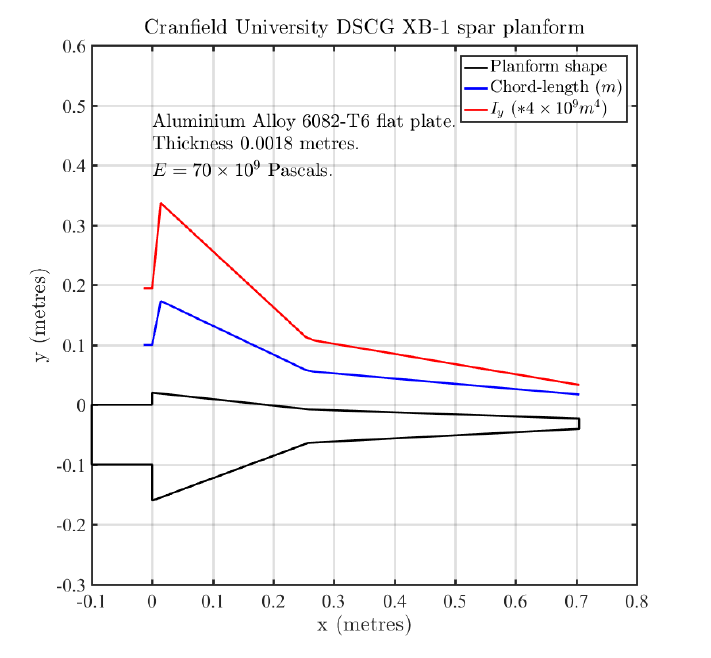
Figure 11. Wing spar model geometry and mechanical properties.